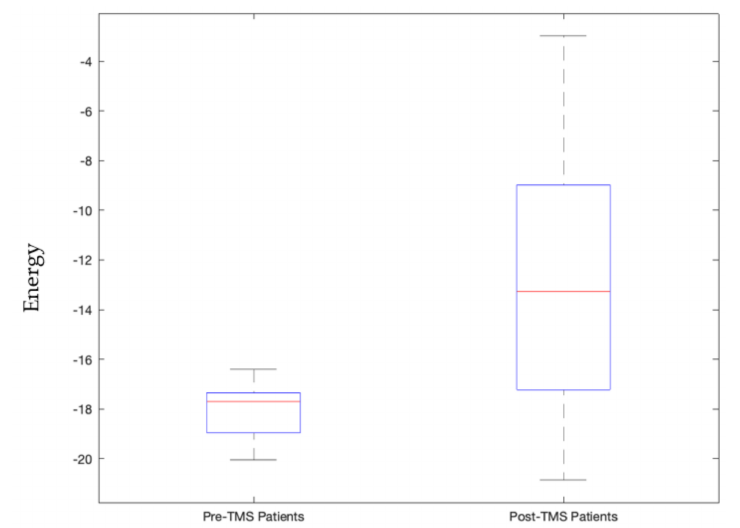
Figure 4. Energy values of patients during pre-TMS subthreshold pulse stimulation condi- tion significantly differed from their post-TMS subthreshold pulse stimulation condition with a p -value = 0.000036 for the active visual network energy state. TMS subthreshold pulse was adminis- tered at the left motor cortex.